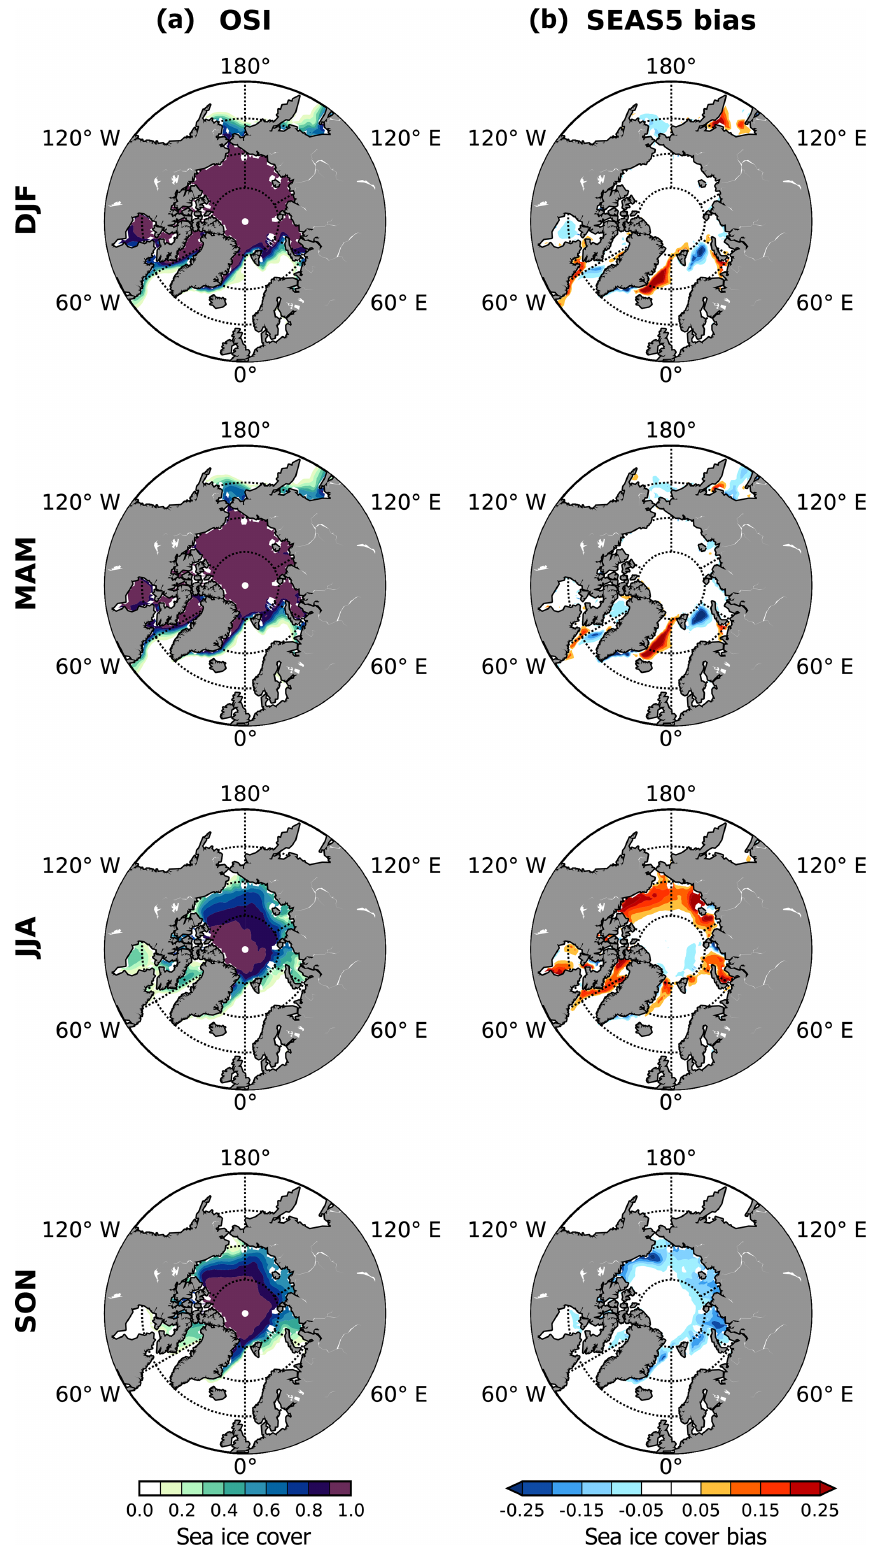
Figure 15. SEAS5 Arctic sea-ice concentration biases (b) , relative to OSI-450 climatology (a) at 1 month lead time. Due to gaps in the satellite record, a small number of seasons had to be excluded from this analysis (see Sect. 3.2 for